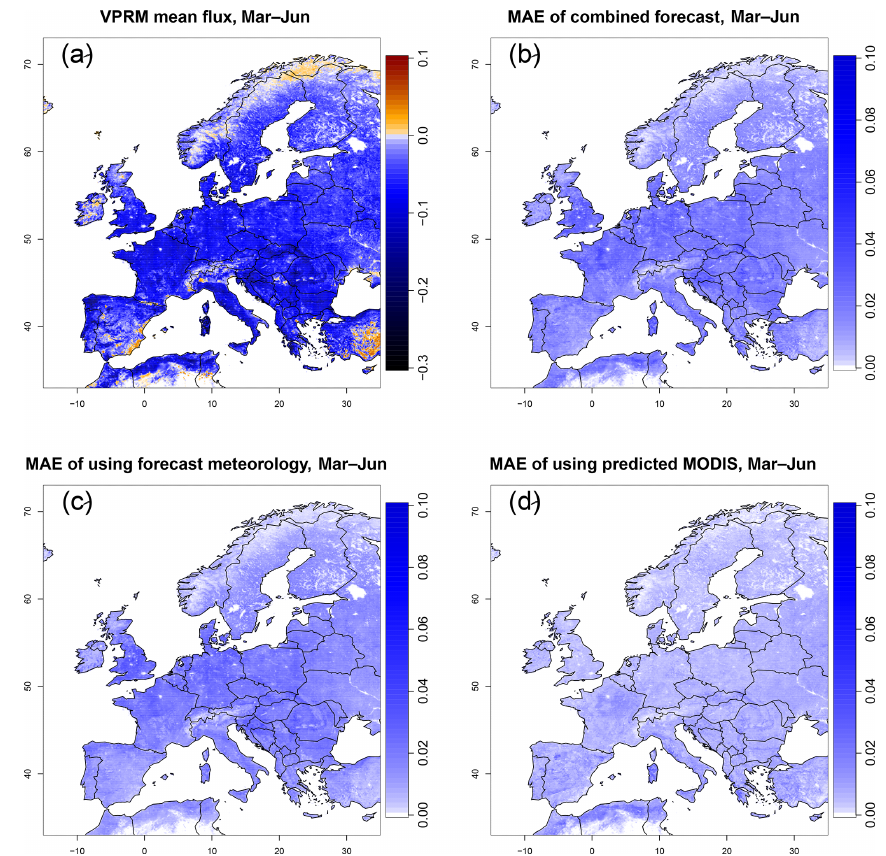
Figure 10. (a) Mean VPRM NEE, during March to June 2014. (b) Spatial distribution of MAE for forecast error; (c) spatial distribution of MAE for meteorological error; (d) spatial distribution of MAE for MODIS error. The MAE of total forecast error in (b) has strong spatial relationship with the VPRM mean flux in (a) , which indicates that the forecast error has a similar impact in all places. Panels (c) and (d) are consistent with Table 3, in that the forecast error is larger than the error from MODIS